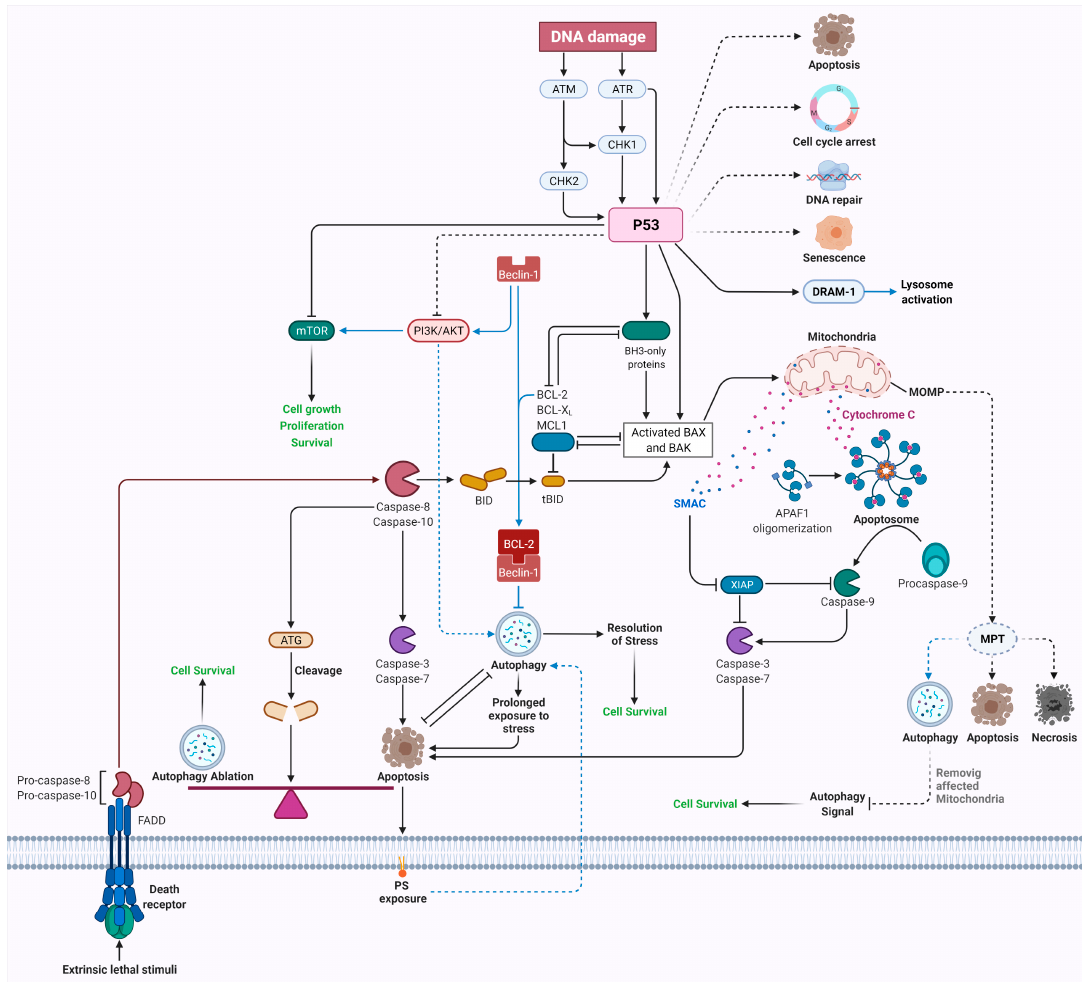
Figure 7. Crosstalk between apoptosis and autophagy. There is complex crosstalk between these two pathways, and they interact in different ways and situations. P53 is the master regulator of cell death and is activated via various cellular inputs, e.g., in response to DNA damage. Activation of P53 leads to apoptosis while inhibiting autophagy. Additionally, apoptosis can activate or inhibit autophagy based on the cell status. The mitochondrial outer membrane potential is disrupted upon activation of the intrinsic apoptosis pathway, leading to MPT. In this situation, the number of affected mitochondria determines the cell fate. If only a few mitochondria are affected, autophagy activity can eliminate them, leading to cell survival. However, when there are more mitochondria affected, apoptotic death will be the cellular fate. In certain situations, when the majority of mitochondria are affected by MPT, the cell undergoes necrosis. In addition, caspases are major proteins in apoptotic pathways whose enzymatic activity can activate the autophagy pathway by cleaving the precursor of ATG proteins or suppress autophagy by cleaving ATG proteins. Autophagy, in turn, could activate or suppress apoptosis. For instance, phosphatidylserine exposure following apoptosis could be a save-me or eat-me signal which activates autophagy. The stress level could tip the balance between life and death through autophagy activity. Autophagy can save cells by cleaning malfunctioning proteins, organelles, and so forth, or, upon prolonged exposure to stress, it can activate cell death. DRAM-1: DNA damage-regulated autophagy modulator 1; MOMP: mitochondrial outer membrane permeabilization; MPT: mitochondrial permeability transition; SMAC: second mitochondria-derived activators of caspases; FADD: Fas-associated death domain protein; PS: phosphatidylserine. The illustration is created with